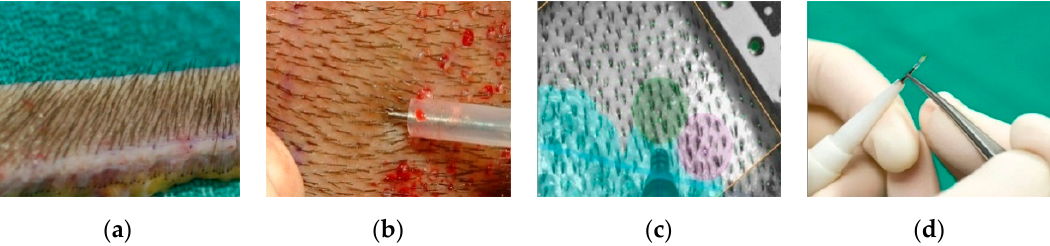
Figure 1. Hair follicle (HF) extraction: ( a ) Strip harvesting, ( b ) follicular unit extraction (FUE), and ( c ) ARTAS. Transplantation methods: ( d ) Manual implanter (KNU implanter).